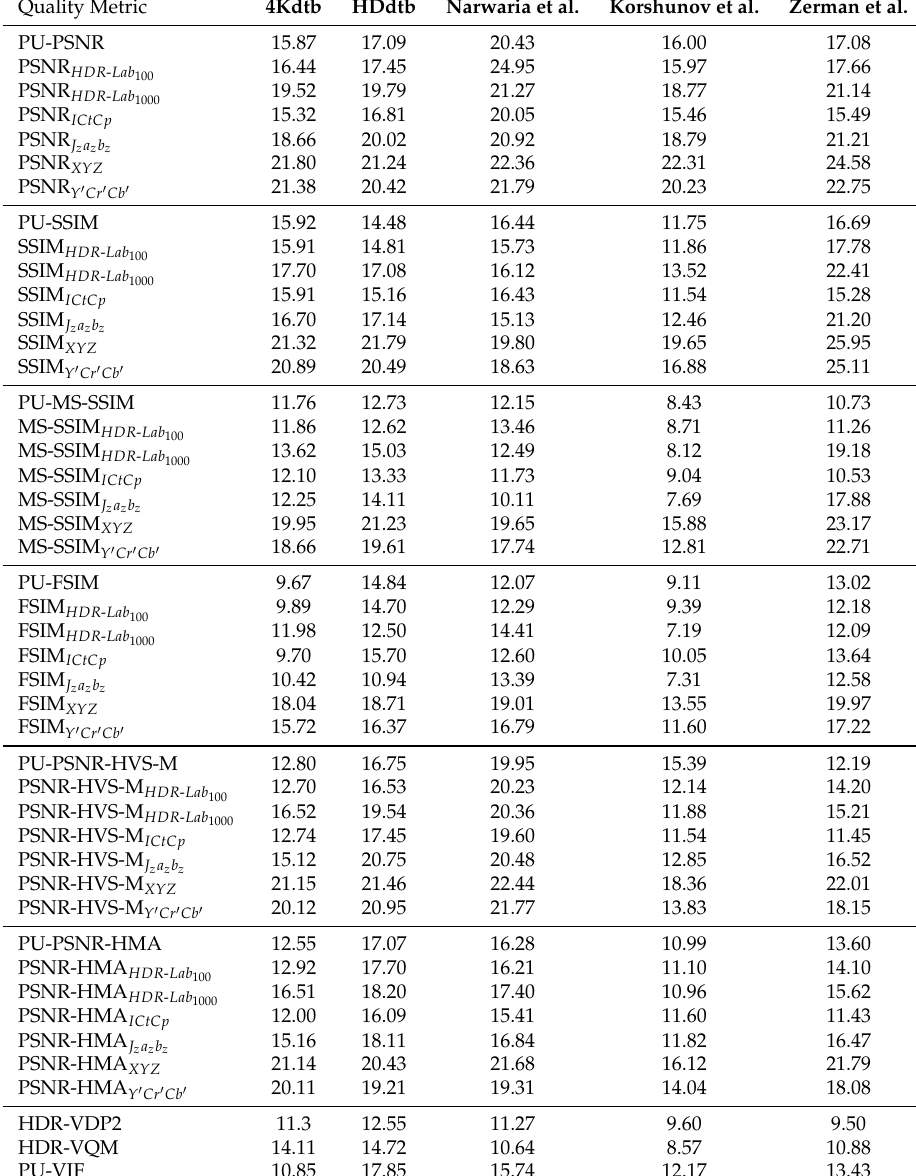
Table A7. RMSE of the different color-blind quality metrics on the considered databases. Quality Metric Narwaria et al. Korshunov et al. Zerman et